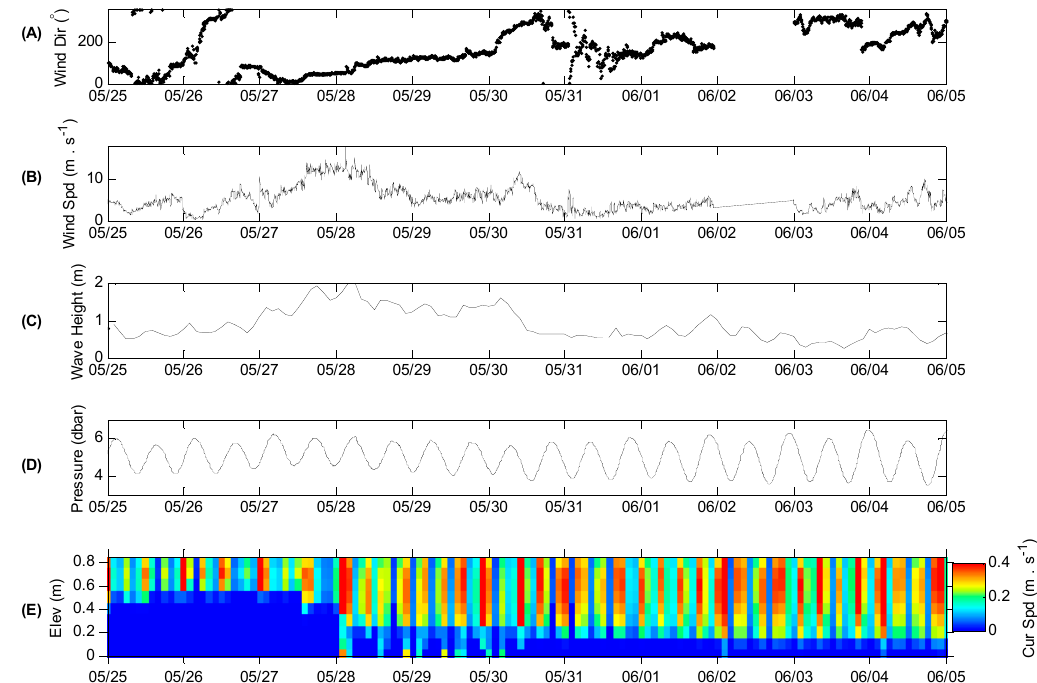
Figure 2. ( A ) Wind direction and ( B ) speed from Fort Pulaski, GA; panels ( C – F ) are data from R1 site collected between March 15 and June 12, 2012. ( C ) Wave height and ( D ) pressure are based on an upward-looking acoustic wave and current profiler (AWAC). ( E ) Current speed is from the pulse- coherent acoustic Doppler current profiler (PCADP). ( F ) Suspended sediment concentration is from a downward-looking acoustic backscatter sensor (ABS). The rectangle highlights the passing of Tropical Storm Beryl in late May 2012.